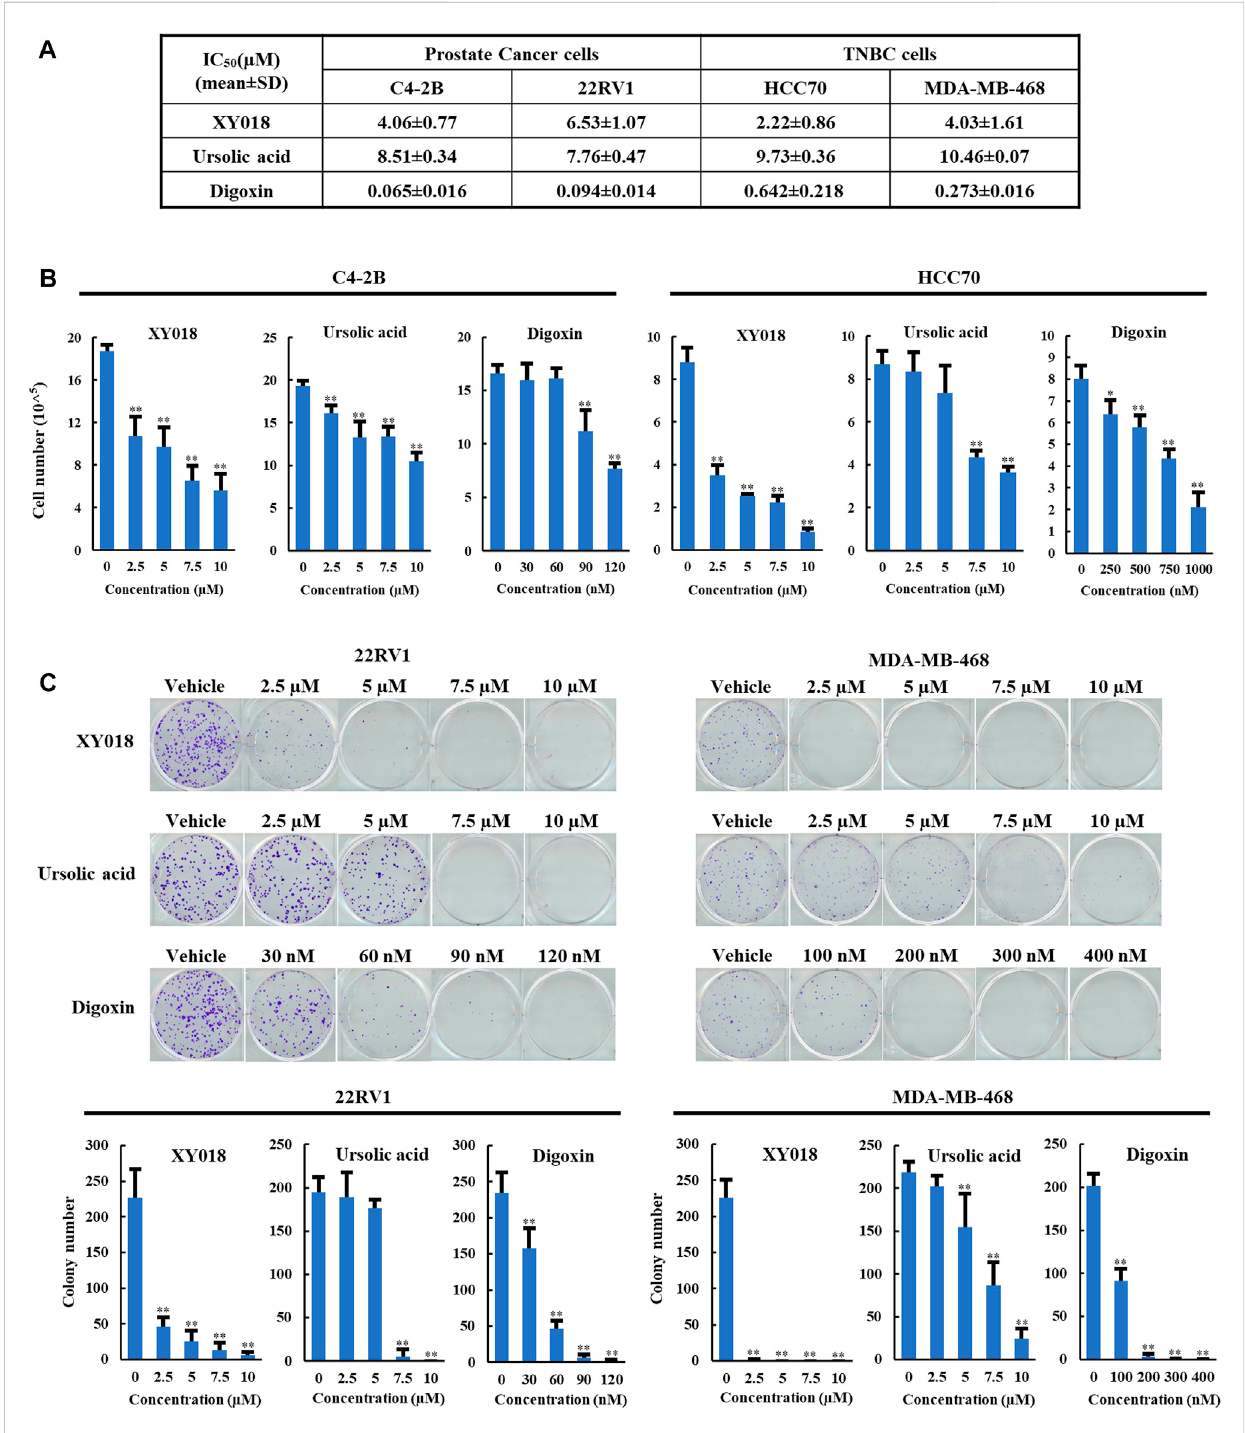
FIGURE 1 UA and digoxin display different effectiveness in inhibition of cancer cell growth when compared to synthetic ROR γ antagonist XY018. (A) . The growth inhibition IC 50 ( μ M) for synthetic ROR γ antagonist XY018, natural ROR γ antagonists ursolic acid and digoxin in indicated PCa and TNBC cell lines treated for 4 days. (B) . C4-2B and HCC70 cells were treated by different ROR γ antagonists as indicated. Viable cells were counted after 4 days. Data are shown as mean ± SD. n = 3. Student ’ s t-test. * p < 0.05, ** p < 0.01. (C) . 22RV1 and MDA-MB-468 cells were treated by different ROR γ antagonists as indicated. Fourteen days later, representative images of colony formation were taken (top) and colonies were counted (bottom). Data are shown